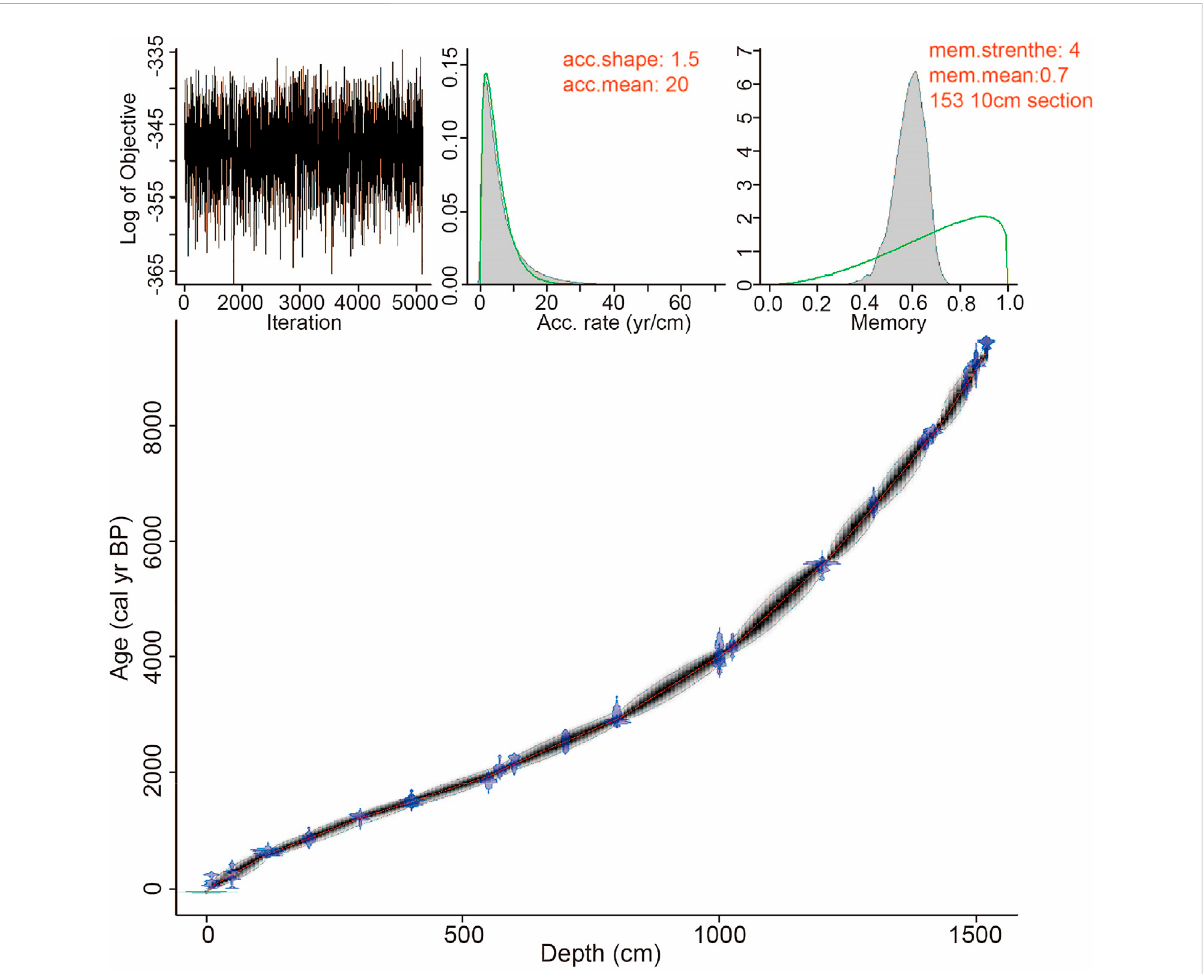
FIGURE 7 Age-depth model for theLake Kalakulisedimentsequence KL13-4 producedby Bacon 2.2(light bluesymbols are 14 C dates, thereddashedline shows the weighted mean ages and grey dashed lines show 95% con fi dence